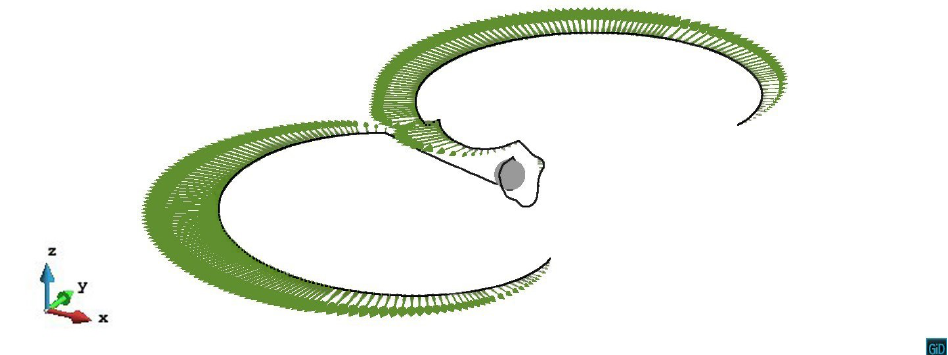
Figure 6. The dislocation topology and nodal velocity vectors of the dislocation line with the primary slip plane z / R = 1.0. The plastic strain ε = 2.69 × 10 − 4